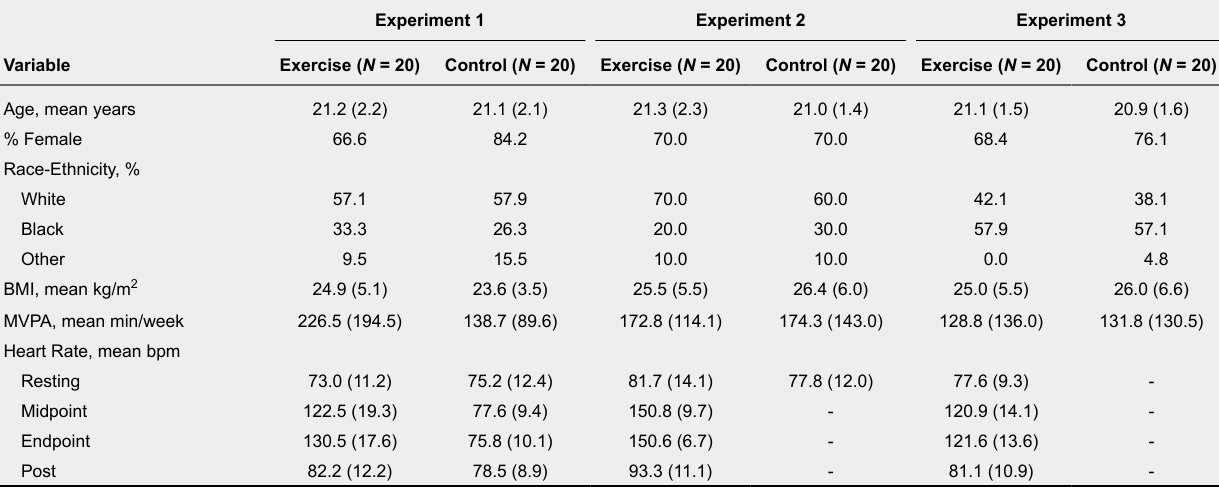
Characteristics of the Study Variables across the Three